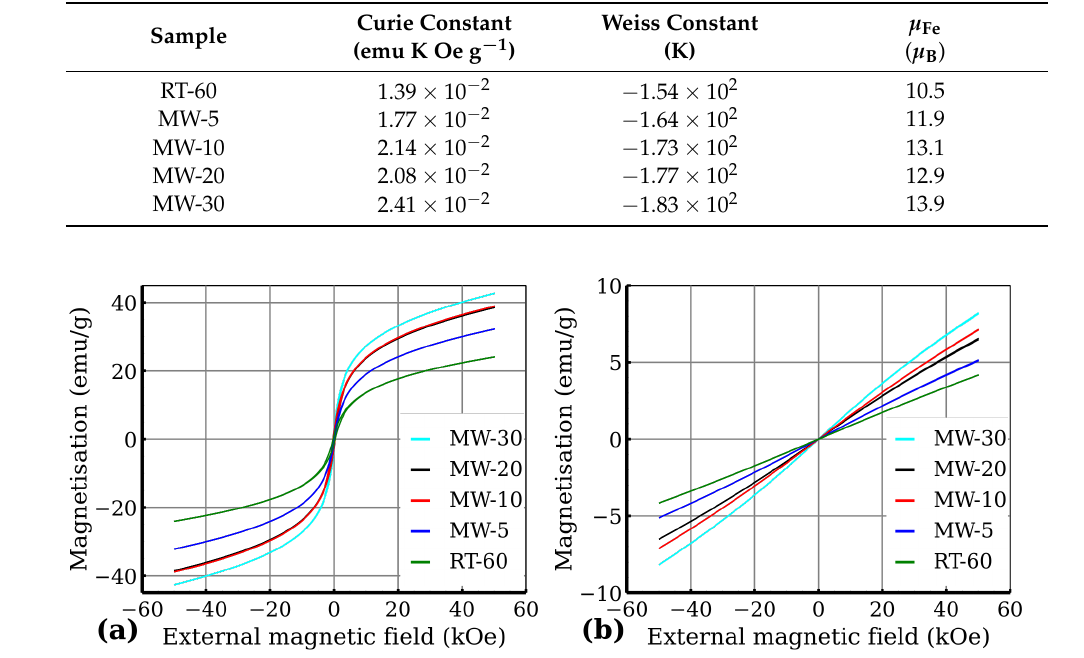
RT-30; Figure S2: XRD pattern and Rietveld fit of sample RT-60; Figure S3: XRD pattern and Rietveld fit of sample RT-90; Figure S4: XRD pattern and Rietveld fit of sample MW-5; Figure S5: XRD pattern and Rietveld fit of sample MW-10; Figure S6: XRD pattern and Rietveld fit of sample MW-20; Figure S7: XRD pattern and Rietveld fit of sample MW-30; Figure S8: Room temperature Mössbauer spectra RT-30; Figure S9: Room temperature Mössbauer spectra RT-60; Figure S10: Room temperature